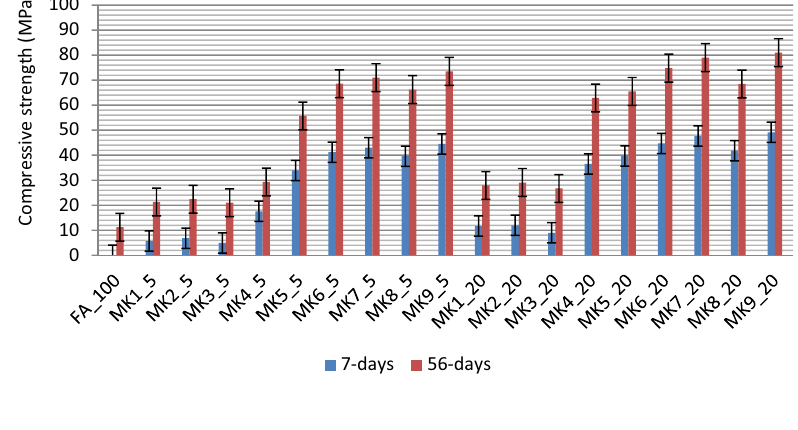
Fig. 5 Compressive strength evolution at room temperature of geopolymer paste with vari- ous types and percentages of